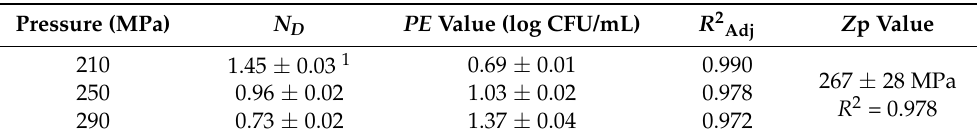
Table 2. Decimal reduction pressure pulse number ( N D , mean ± SE) and pulse effect ( PE , mean ± SE) on E. coli in frozen carrot